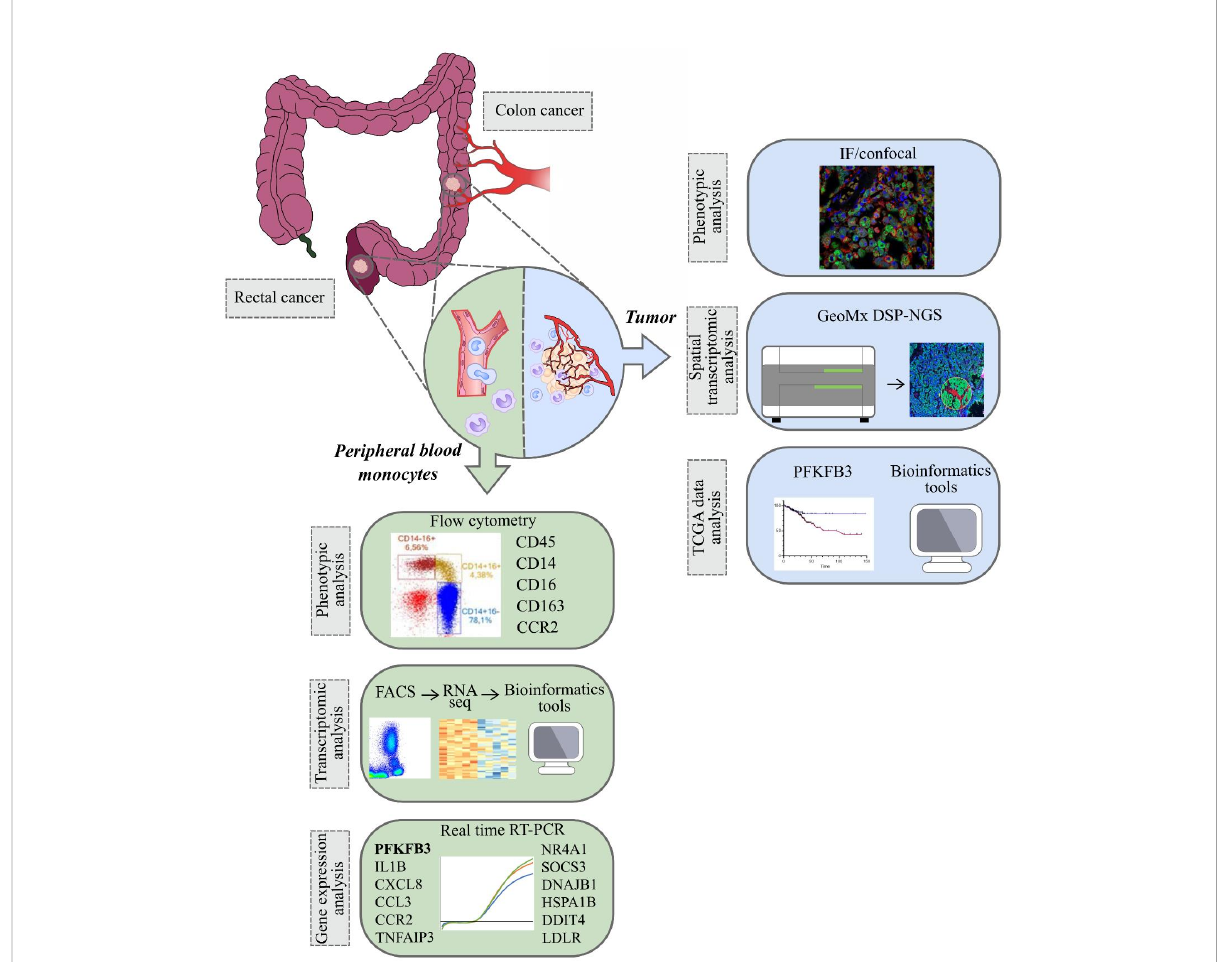
FIGURE 1 The overall study design. The samples (monocytes and tumor tissue) were collected from patients with colon and rectal cancers (1). Peripheral blood monocytes were characterized by phenotypic analysis using fl ow cytometry, by transcriptomic analysis using RNA sequencing (Illumina technology) and by gene expression analysis using real-time RT-PCR (2). In tumors of colon and rectum, phenotypic analysis was performed with IF/confocal microscopy. Spatial transcriptomic analysis was applied using GeoMX DSP-NGS (Nanostring technology). TCGA data were obtained for survival analysis and correlations with the parameters of progression in colon and rectal cancers. All patients` cohorts and technologies are described in the